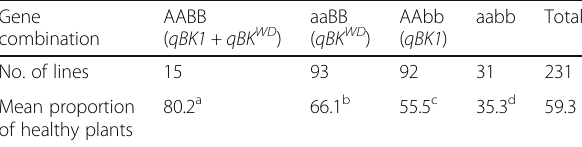
Table 2 Mean proportion of healthy plants harboring individual gene combinations infected with Fusarium fujikuroi isolate CF283 Gene AABB aaBB AAbb aabb Total combination ( qBK1 + qBK WD ) ( qBK WD ) ( qBK1 ) No. of lines 15 93 92 31 231 Mean proportion 80.2 a 66.1 b of healthy plants Means with different characters of superscripts (a, b, c and d) indicate significant differences at P